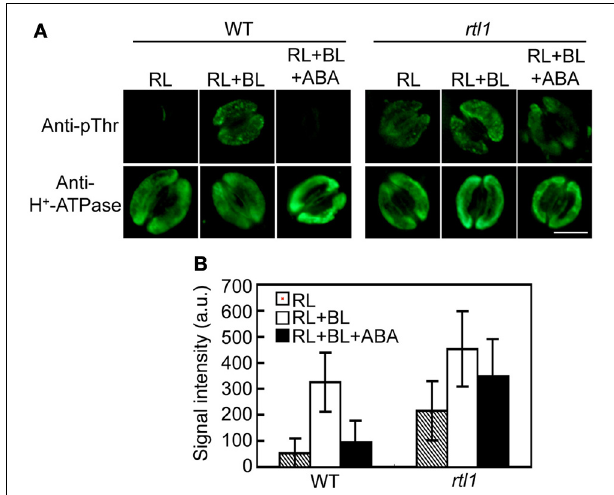
FIGURE 2 | Effect of ABA on blue light (BL)-induced H + -ATPase phosphorylation in stomatal guard cells of the rtl1 mutant. Epidermal fragments of rosette leaves from WT and rtl1 mutant plants were illuminated with red light (RL) for 20min and then illuminated by BL superimposed on the background RL (RL+BL) for 2.5min. ABA (20 µ M) was added to epidermal fragments 20min before BL illumination commenced (RL + BL + ABA). (A) Typical images of stomata immunostained using anti-pThr and anti-H + -ATPase antibodies. Scale bar = 10 µ m. (B) Fluorescent signal intensities from stomata immunostained with anti-pThr antibody. Values represent the mean ± SD ( n = 30) in arbitrary units (a.u.). The experiment was repeated three times on different occasions with similar results.